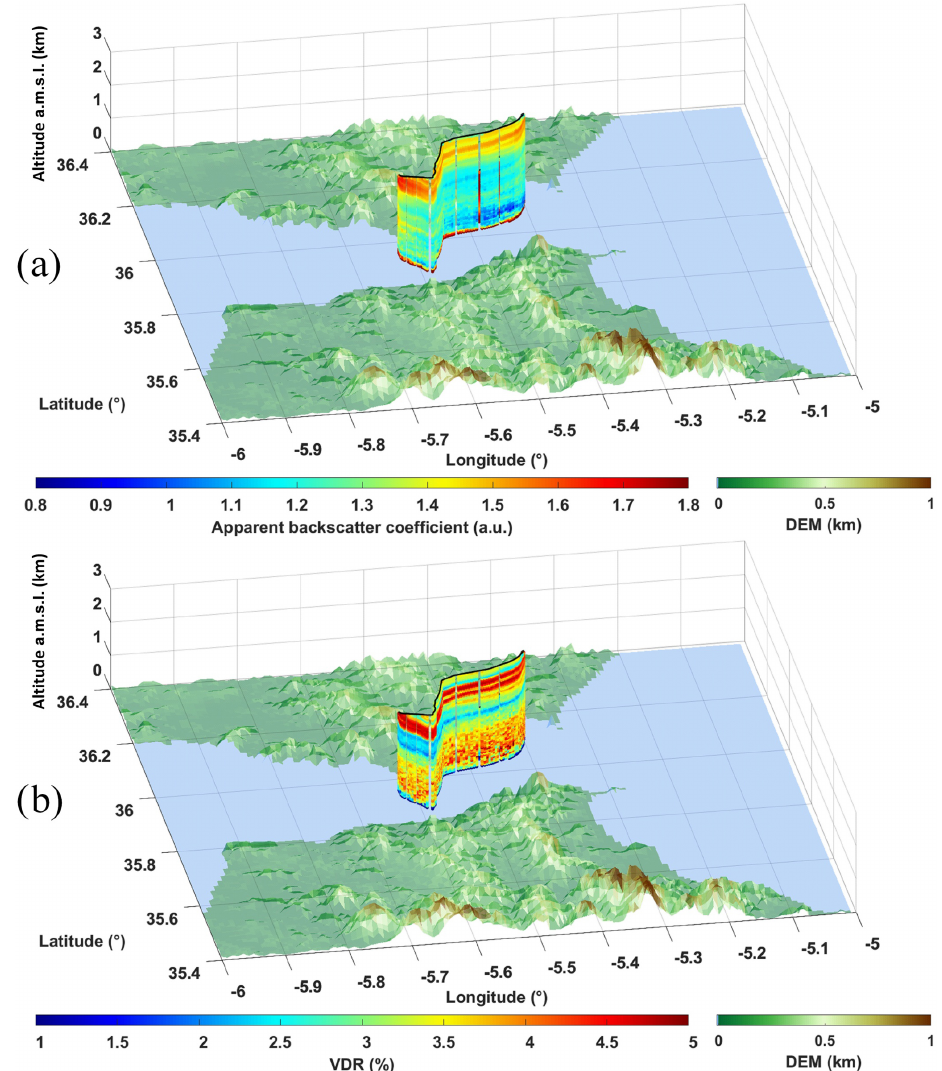
Figure 4. Lidar profiles derived from ULICE on board the ULA above the Strait of Gibraltar: (a) the apparent backscatter coefficient and (b) the volume depolarization ratio (VDR). DEM stands for digital elevation model.